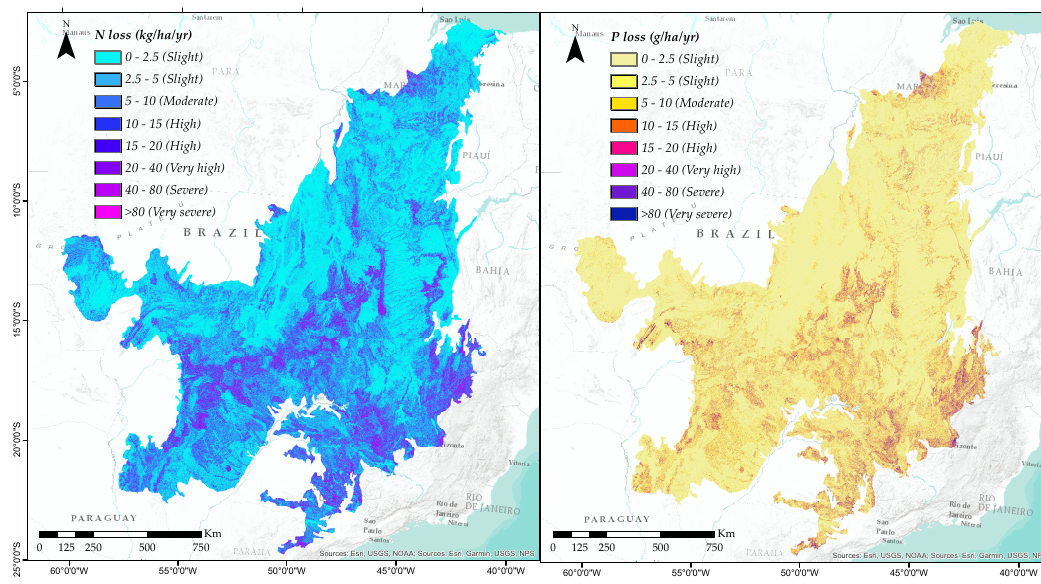
Figure 6. Map of potential nitrogen (kg N ha − 1 yr − 1 ) and phosphorus (gP ha − 1 yr − 1 ) loss rate for the Brazilian Cerrado (Reference year: